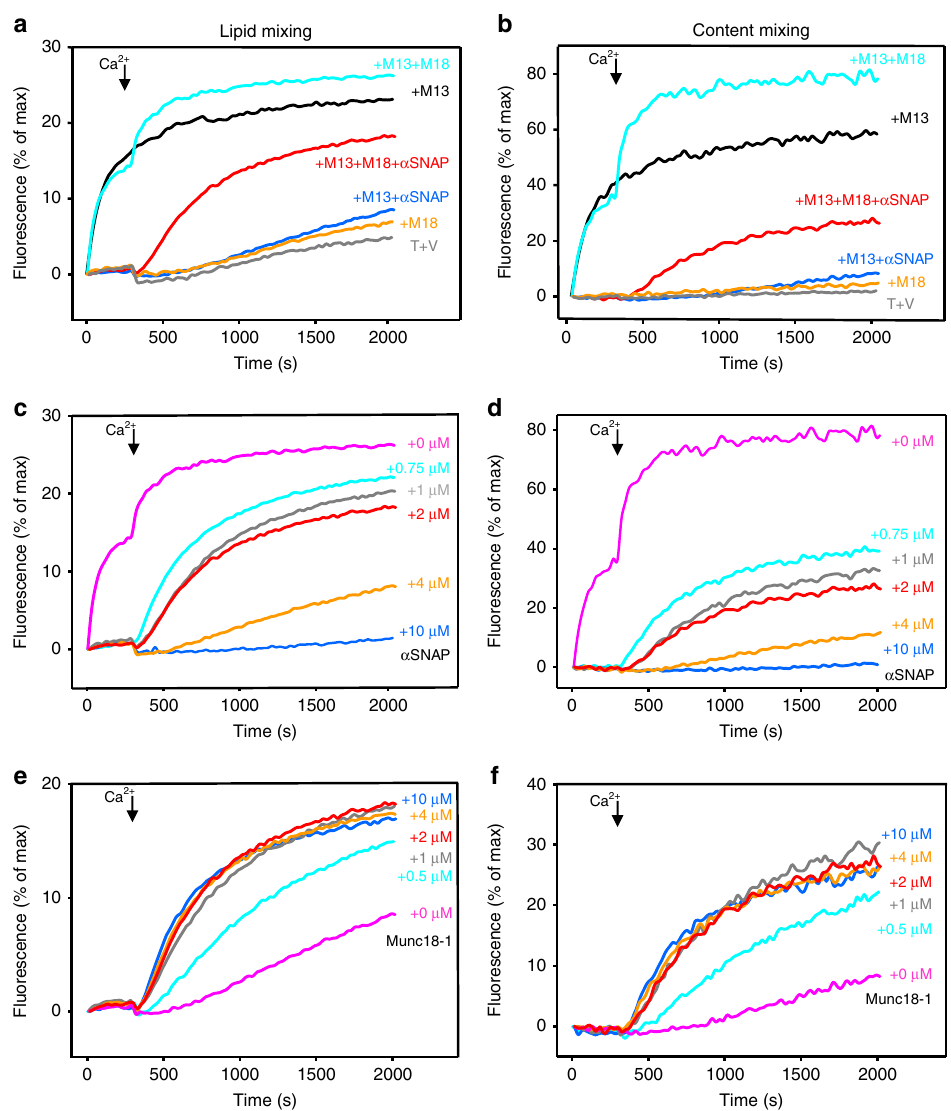
Fig. 2 Munc18-1 partially overcomes the inhibition of fusion between T- and V-liposomes by α SNAP. a – f Lipid mixing ( a , c , e ) between V- and T-liposomes was monitored from the fl uorescence de-quenching of Marina Blue lipids and content mixing ( b , d , f ) was monitored from the increase in the fl uorescence signal of Cy5-streptavidin trapped in the V-liposomes caused by FRET with PhycoE-biotin trapped in the T-liposomes upon liposome fusion. In a , b , assays were performed with V- and T-liposomes alone (T + V) or including different combinations of 1 µ M Munc18-1 (M18), 0.5 µ M M13C 1 C 2 BMUNC 2 C (M13), and 2 µ M α SNAP as indicated by the color-coded labels. Assays in c , d included constant concentrations of M13C 1 C 2 BMUNC 2 C (0.5 µ M) and Munc18-1 (1 µ M), and different concentrations of α SNAP, whereas assays in e , f included constant concentrations of M13C 1 C 2 BMUNC 2 C (0.5 µ M) and α SNAP (2 µ M), and variable concentrations of Munc18-1. Experiments were started in the presence of 100 μ M EGTA, 1 µ M excess of SNAP-25, and 5 μ M streptavidin, and then Ca 2 + (600 μ M) was added at 300 s. Source data are provided as a Source Data fi